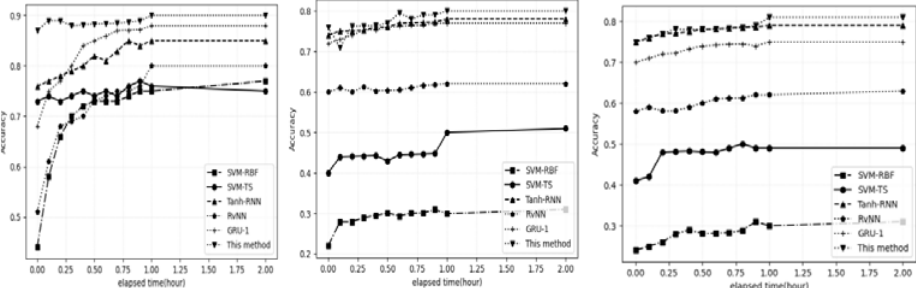
Fig. 3. Early detection results of rumors, from left to right are Weibo, Twitter 15 and Twitter